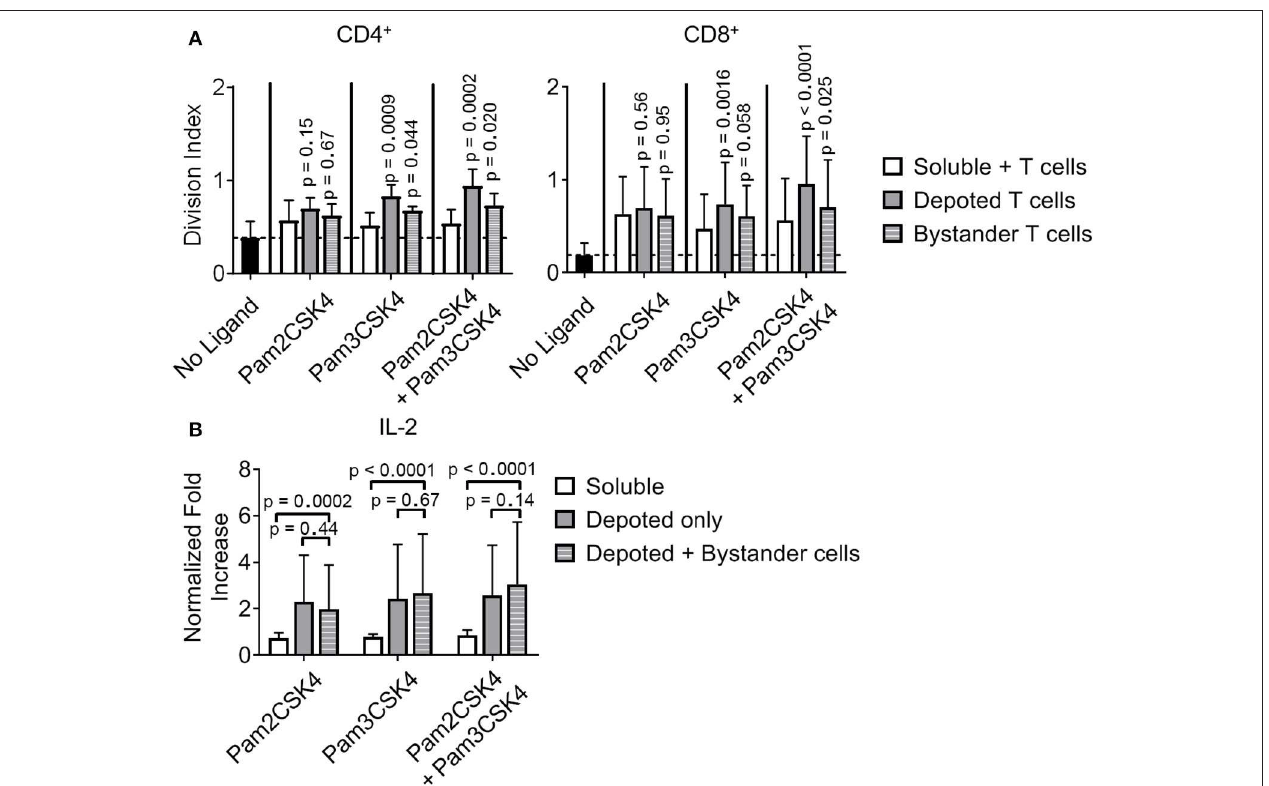
FIGURE 8 | Depoted TLR2 ligands enhance murine T-cell activation by increased cell division and inflammatory IL-2 secretion. (A) Purified polyclonal T cells were stained with 5 µ M of carboxyfluorescein succinimidyl ester (CFSE). Different combinations of cell surface ligands (Pam2CSK4 and Pam3CSK4) were either directly added in solution (soluble) or depoted into polyclonal T cells, and co-cultured with non-depoted T cells and α CD3/CD28 beads for 3 days. Quantification of division index of CD4 + and CD8 + T cells in bulk polyclonal T cells. Dashed lines represent respective averages (mean) of “No Ligand” conditions. p -values within each group were determined by comparing with respective soluble ligand as determined by RM one-way ANOVA with Sidak’s method for multiple comparisons correction. Data showed m ± s.d. ( n = 5 independent samples). (B) IL-2 from cell supernatants was measured by ELISA on day 2. Concentrations were normalized to α CD3/CD28 bead-stimulated T cells in the absence of TLR2 ligand. p -values between indicated pairwise comparisons were determined by two-way ANOVA with Sidak’s method for multiple comparisons correction. Data showed m ± s.d. ( n = 5 independent